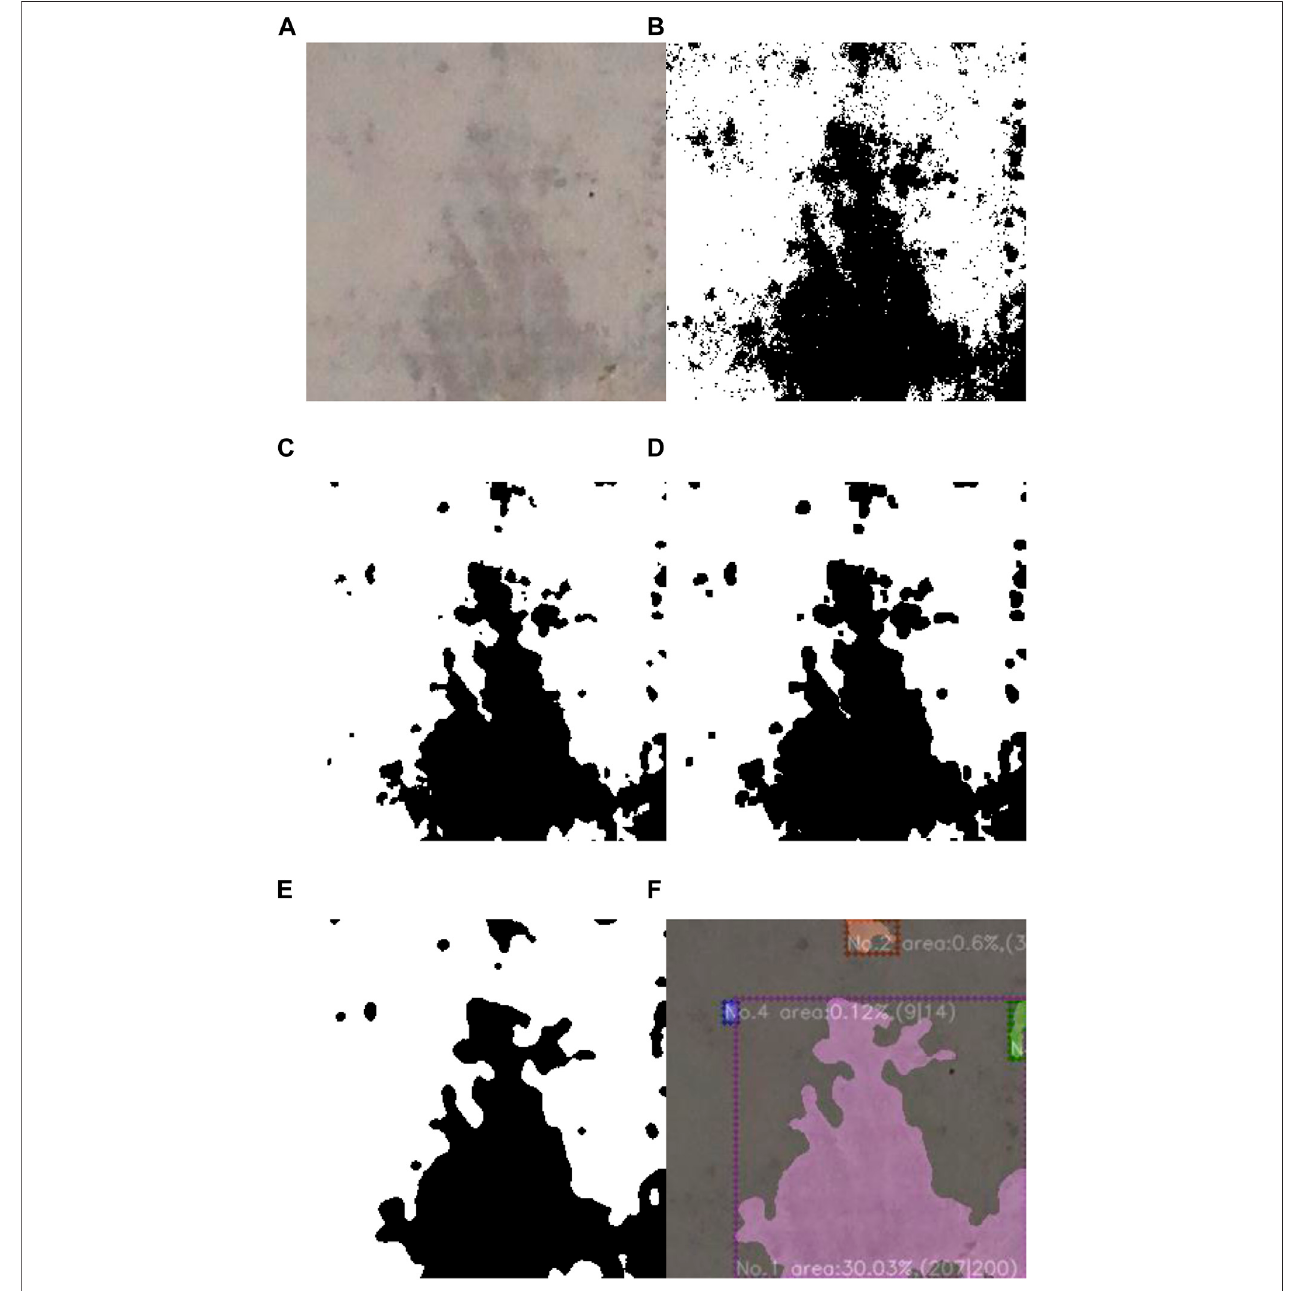
FIGURE13| Quanti fi cationprocessofFFCchromaticaberrationexperimentaldata: (A) Input (B) Colorspacerecognition (C) Median fi lternoisereduction (D) Data open operation (E) Data closure operation (F) Quantitative segmentation.